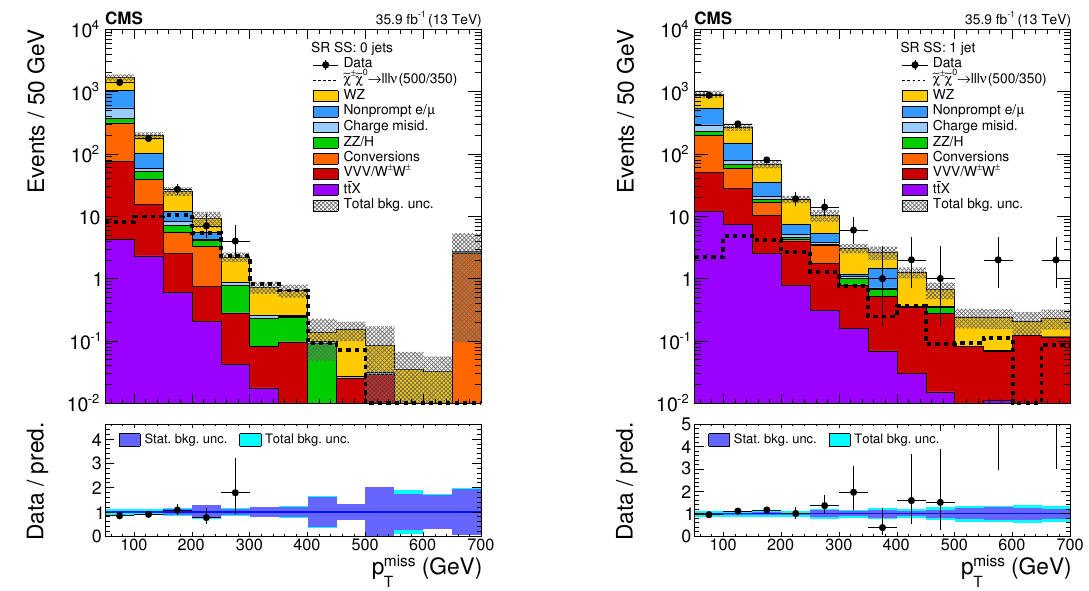
Figure 4 . Distribution of p miss for events with 2 SS leptons and 0 jets (left) or 1 jet (right). T